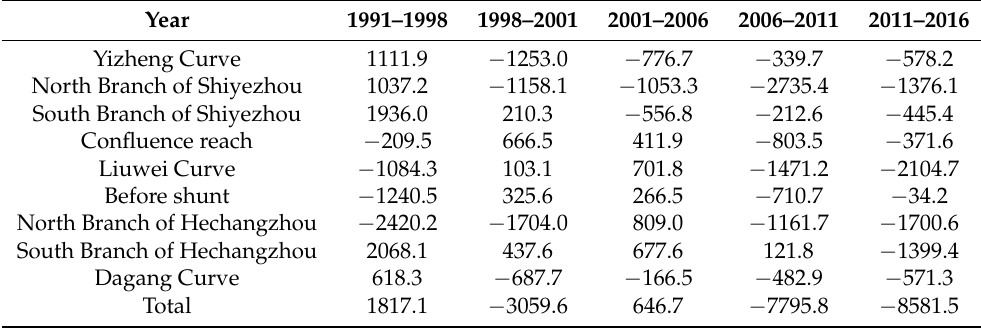
Table 2. Annual average value statistics of flow and sediment at Dotong Station.